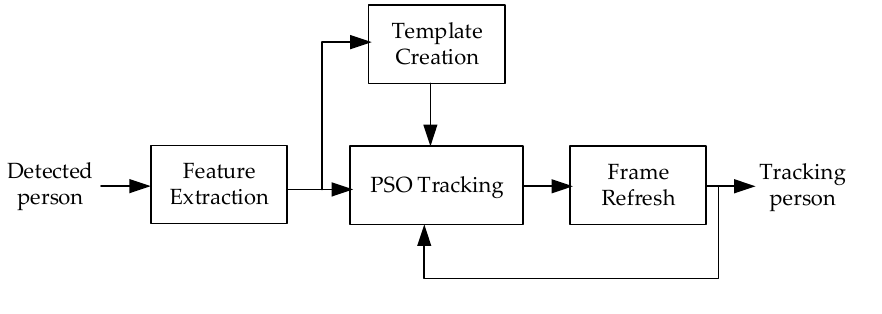
Figure 7. Person Tracking.